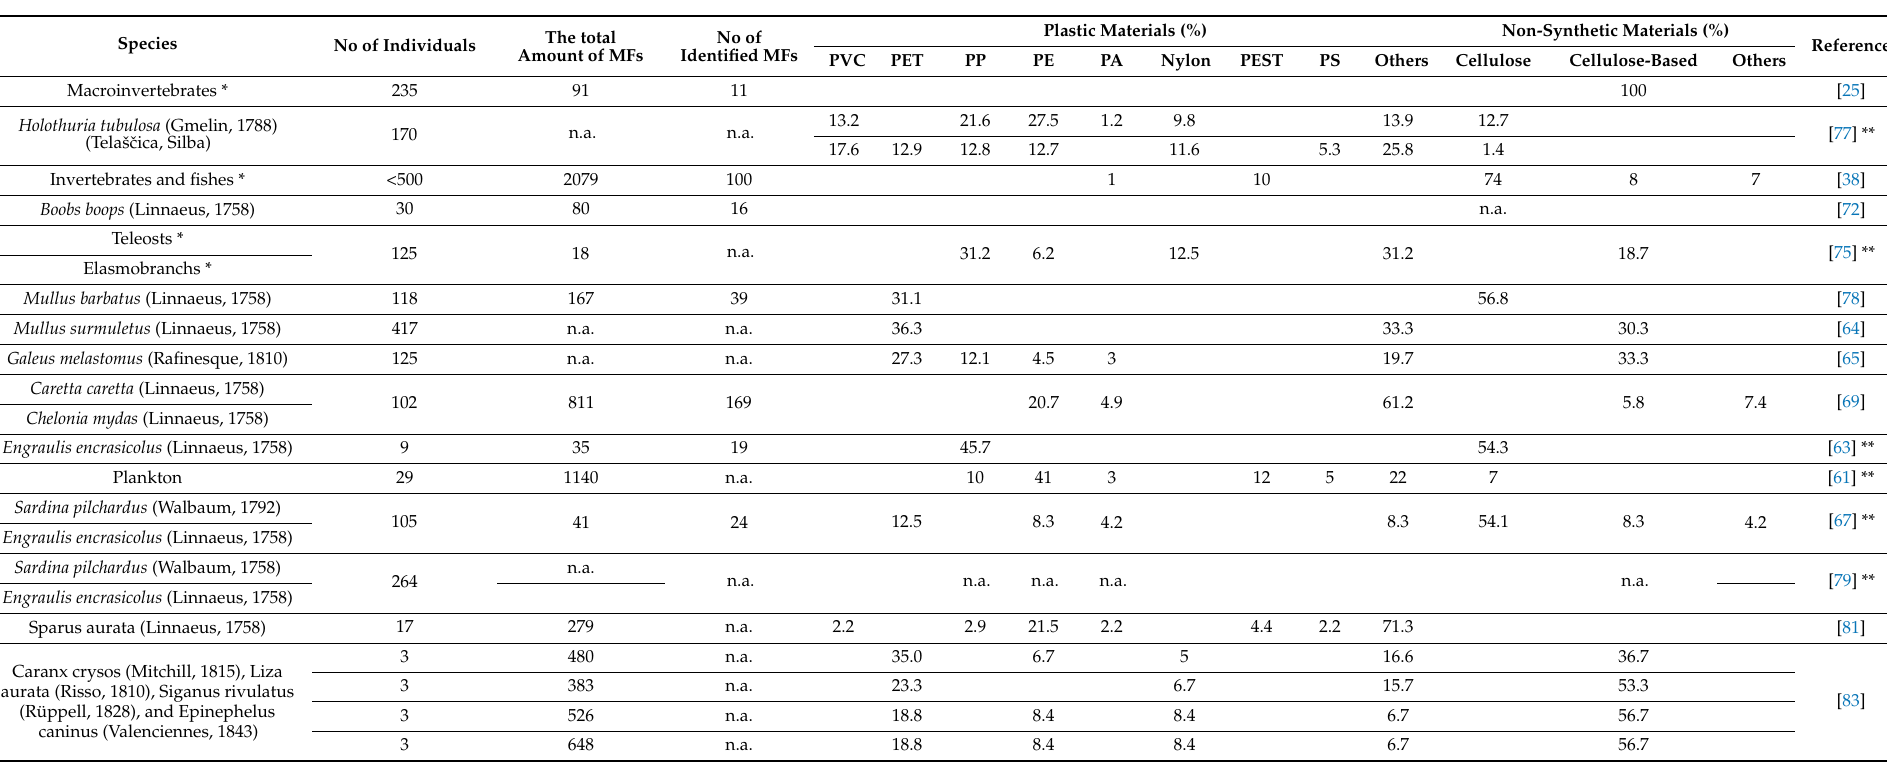
Table 3. The literature data on the abundance of natural (i.e., cellulose), artificial (i.e., cellulose-based), other non-synthetic (i.e., wool, silk) and plastic microfibers in biota (invertebrates, fish and sea turtles) of the Mediterranean Sea, together with the number of specimens sampled and the relative number of fibers found and analyzed. Polyvinyl chloride (PVC), polyethylene terephthalate (PET), polypropylene (PP), polyethylene (PE), polyamide (PA), polyester (PEST), polystyrene